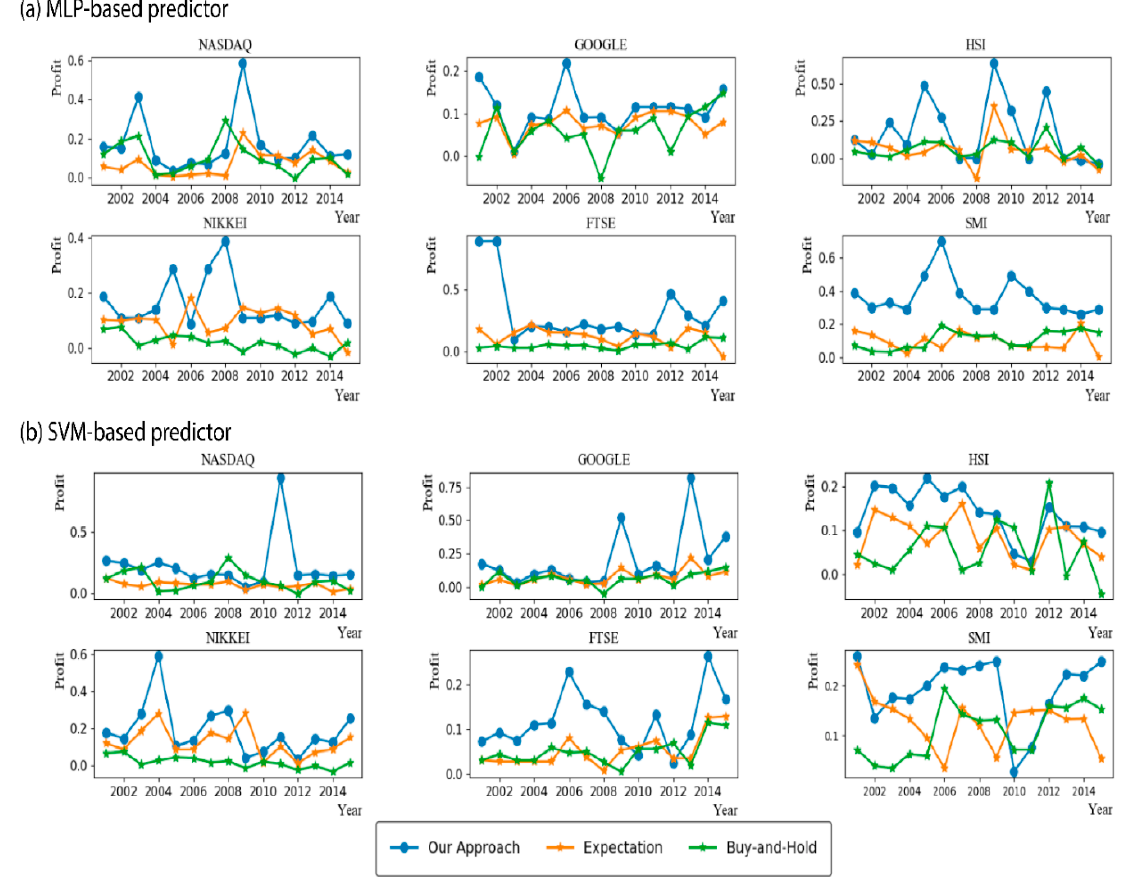
Figure 5. Profit comparison. ( a ) Profit comparison by MLP-based predictor; ( b ) Profit comparison by SVM-based predictor.